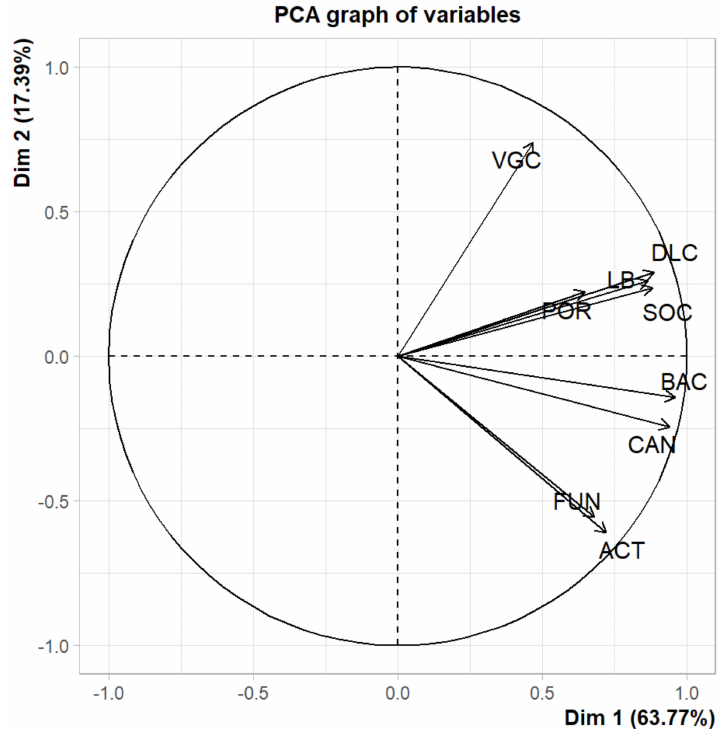
Figure 4. Ordination plot for the principal component analysis. Components 1 and 2 represent 63.8% and 17.4% of the total variance,